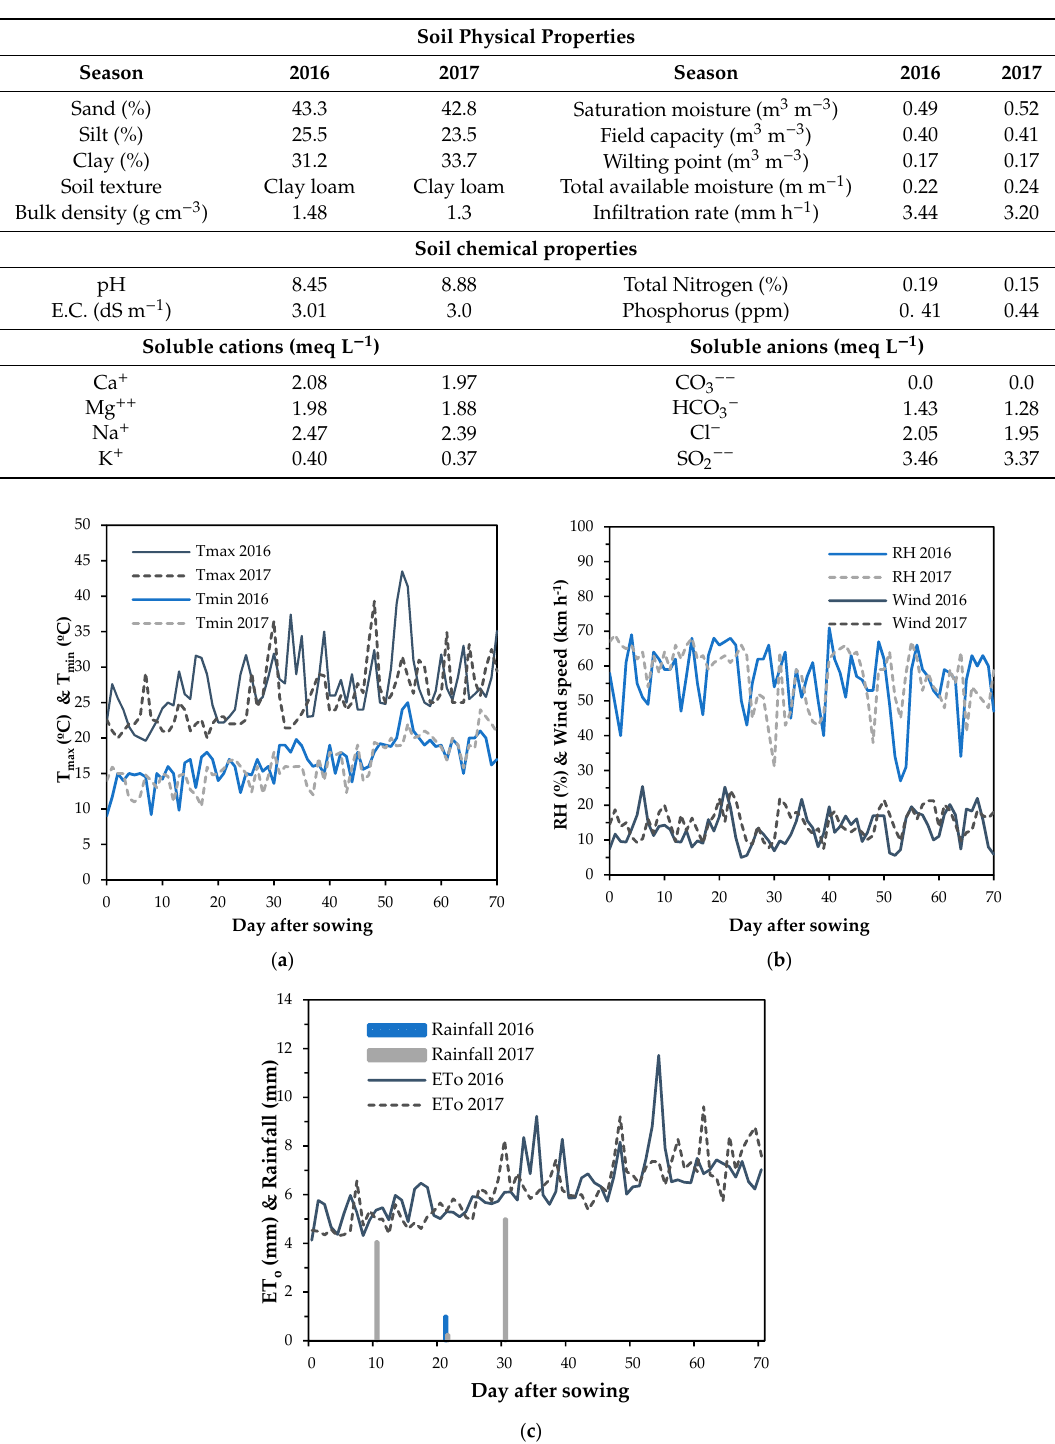
Figure 2. Daily climate parameters in the 2016 and 2017 experimental periods during the Jew’s Mallow growing season. ( a ) daily maximum and minimum air temperature (T max and T min , °C), ( b ) relative humidity (RH, %) and wind speed (km h − 1 ), and ( c ) reference evapotranspiration (ET o , mm) and rainfall (mm).